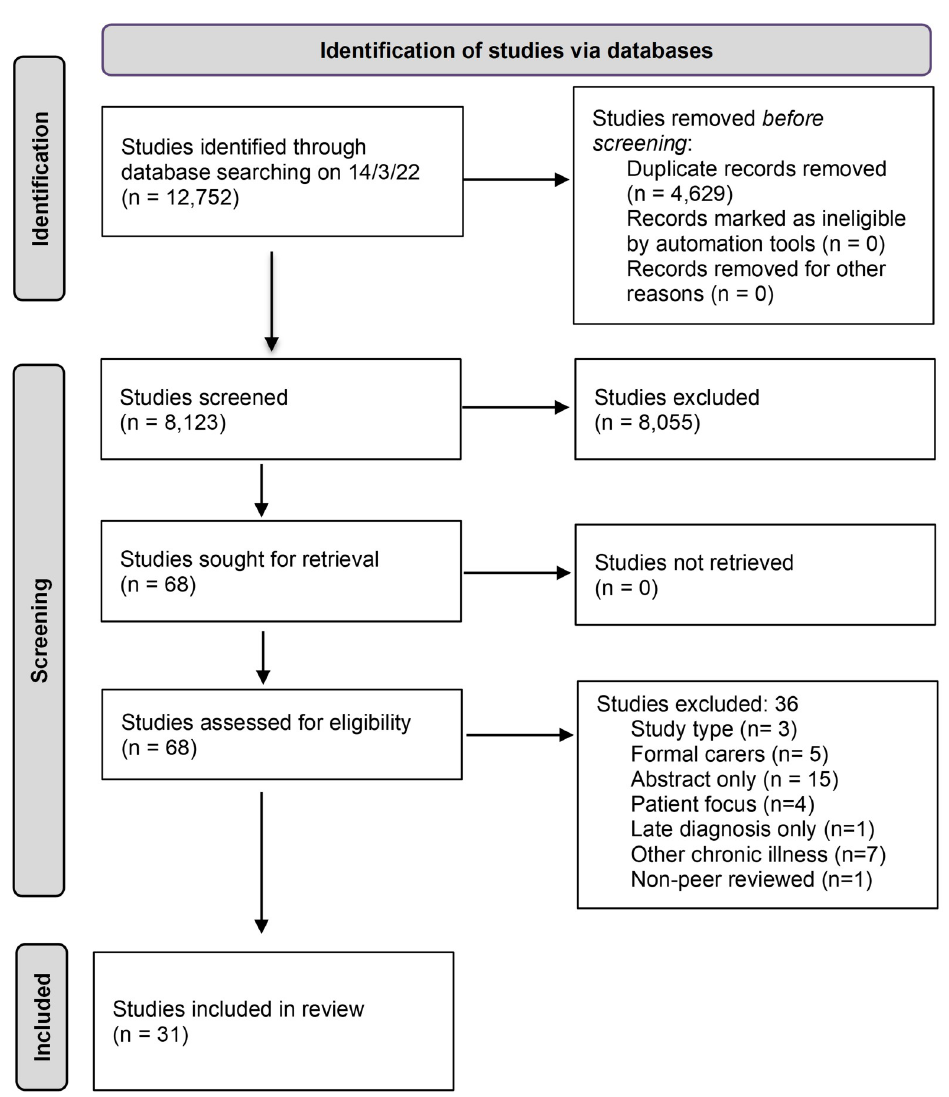
Fig 1. Preferred Reporting Items for Systematic Reviews and Meta-Analyses (PRISMA) flow